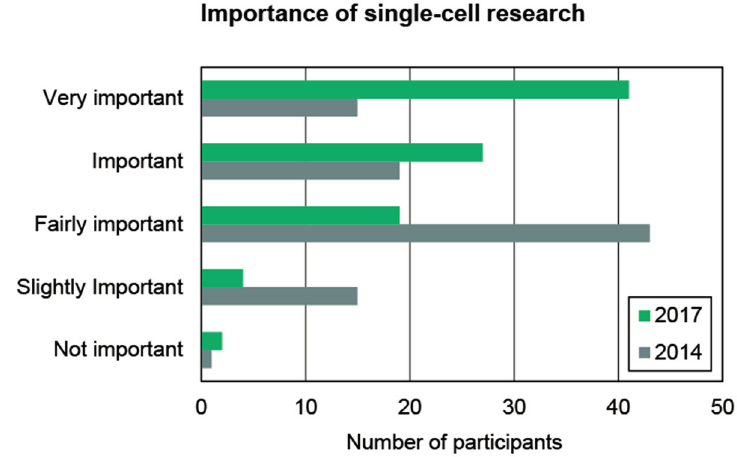
Figure 7. Importance of single-cell analysis to German cell researchers in 2014 and estimated for 2017. This data was derived by a survey amongst 210 participants from German universities, research institutes and industry. A strong growth of interest is expected over the next